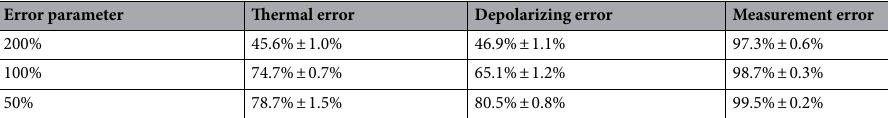
Table 3. Comparison of the correctness when one type of error parameter is doubled or halved in the simulation. Reducing the depolarizing error improves the correctness the